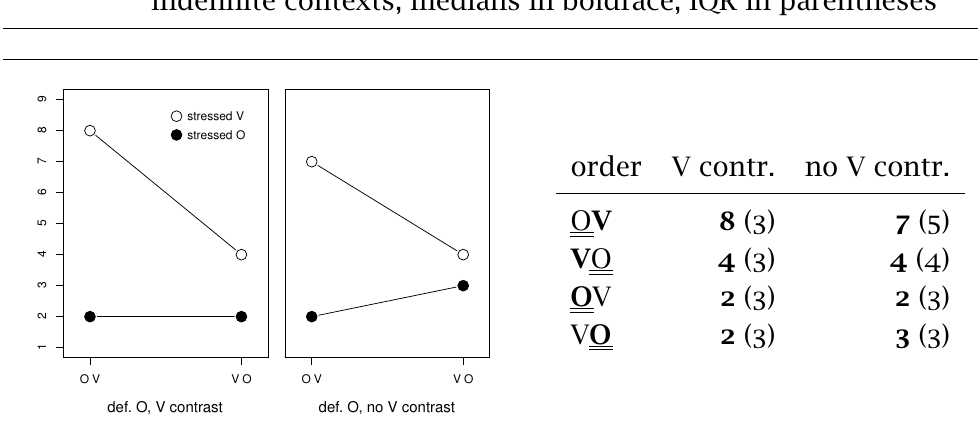
Figure 9 Results of the post-hoc analysis for salient verb contrast in the indefinite contexts; medians in boldface, IQR in parentheses